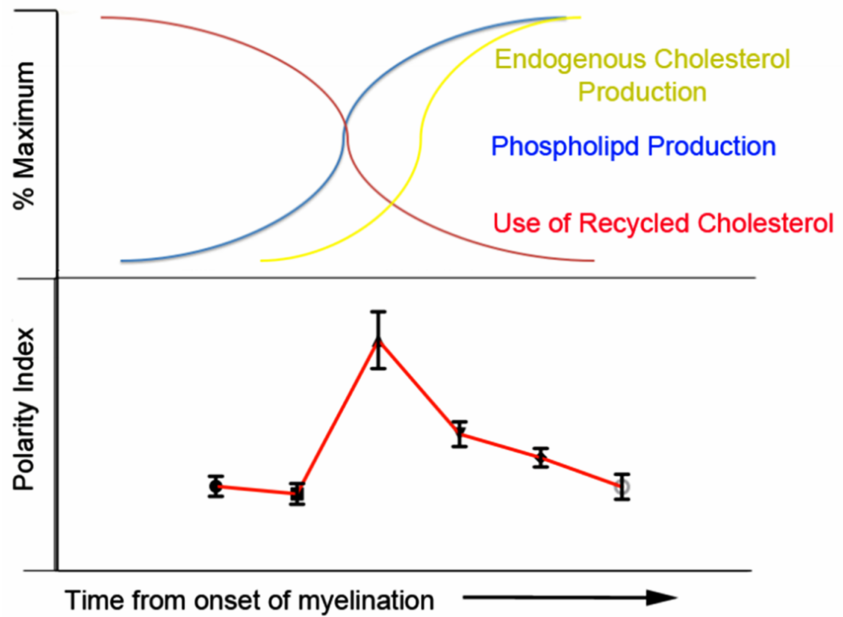
Figure 6. A theory regarding the biphasic evolution of myelin polarity index over early time-points of remyelination. Initially Schwann cells extensively incorporate salvaged cholesterol, generating new myelin with a low polarity (more lipophilic character). Upregulation of phospholipid production occurs during a nadir of cholesterol levels, while the cell is switching from exogenous cholesterol use to endogenous cholesterol production. The dominant addition of phospholipid to the myelin during this time results in a transient increase in the Polarity Index of myelin signatures. Endogenous cholesterol production then reaches full capacity and is gradually incorporated into the phospholipid rich myelin, resulting in a gradual return of myelin Polarity Index to lower, mature levels. These processes occur over approximately two weeks after injury [25–31].